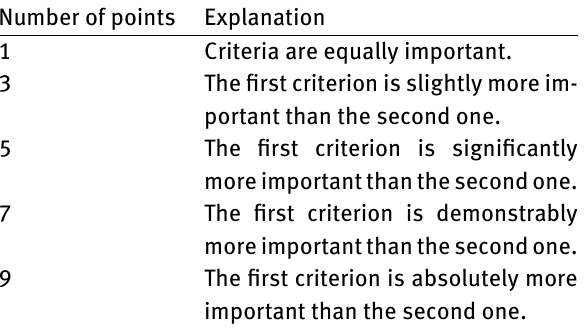
Table 1: Saaty point